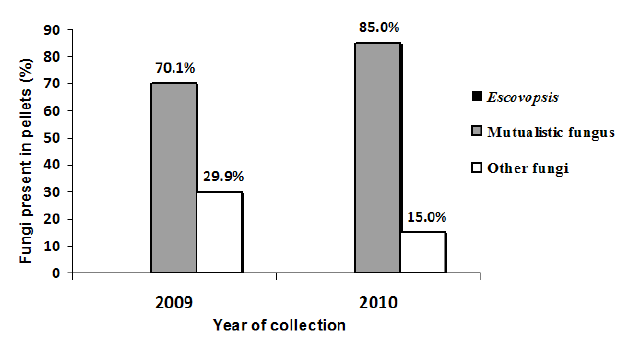
Fig 2 . Prevalence of filamentous fungi in pellets extracted from gynes of Atta sexdens collected in the mating flights of 2009 (n = 127 pellets) and 2010 (n = 140). The specialized parasite fungus Escovopsis was not found in the